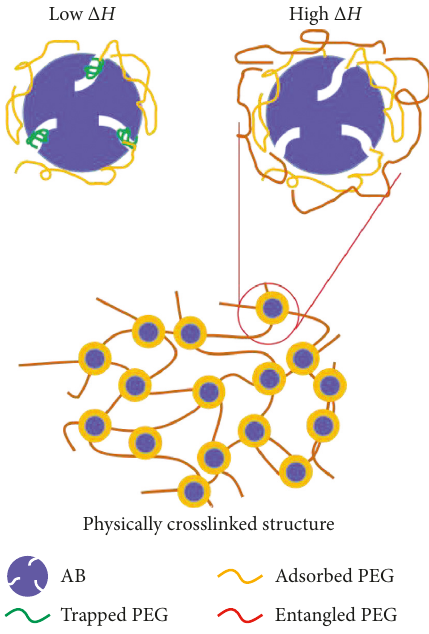
Figure 8: Schematic representation of shape